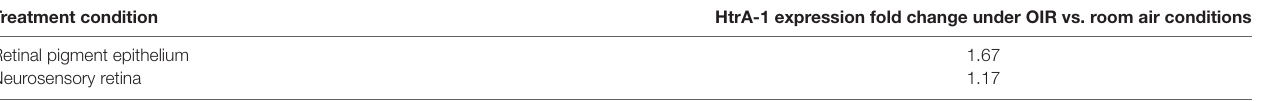
TABLE 5 | Murine retinal and retinal pigment epithelial (RPE) tissues express greater levels of HtrA-1 under oxygen-induced retinopathy (OIR) compared with control conditions. Treatment condition HtrA-1 expression fold change under OIR vs. room air conditions Retinal pigment epithelium 1.67 Neurosensory retina